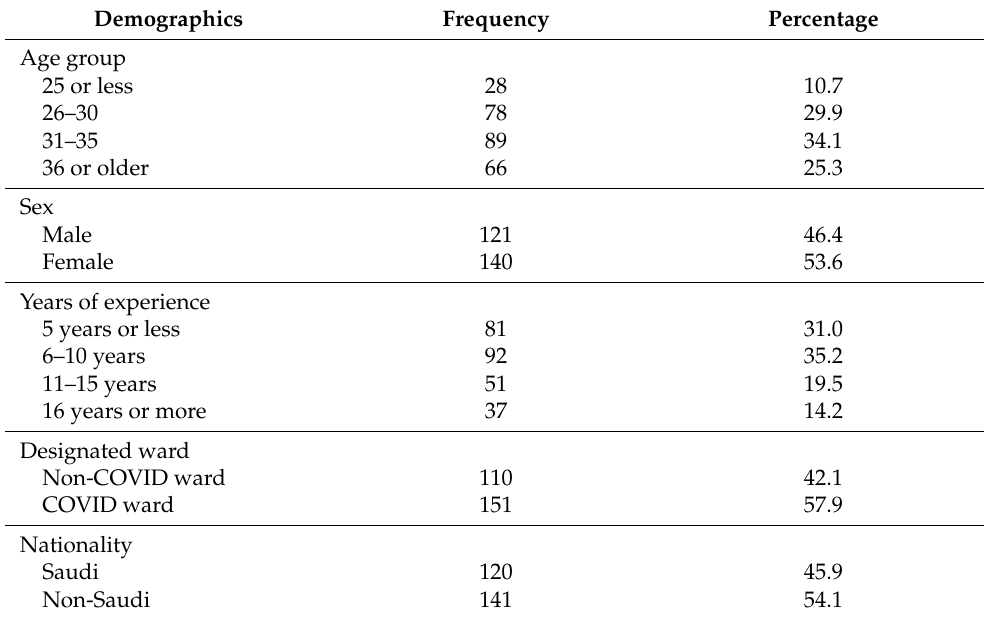
Table 1. Demographic characteristics of staff nurses, n =